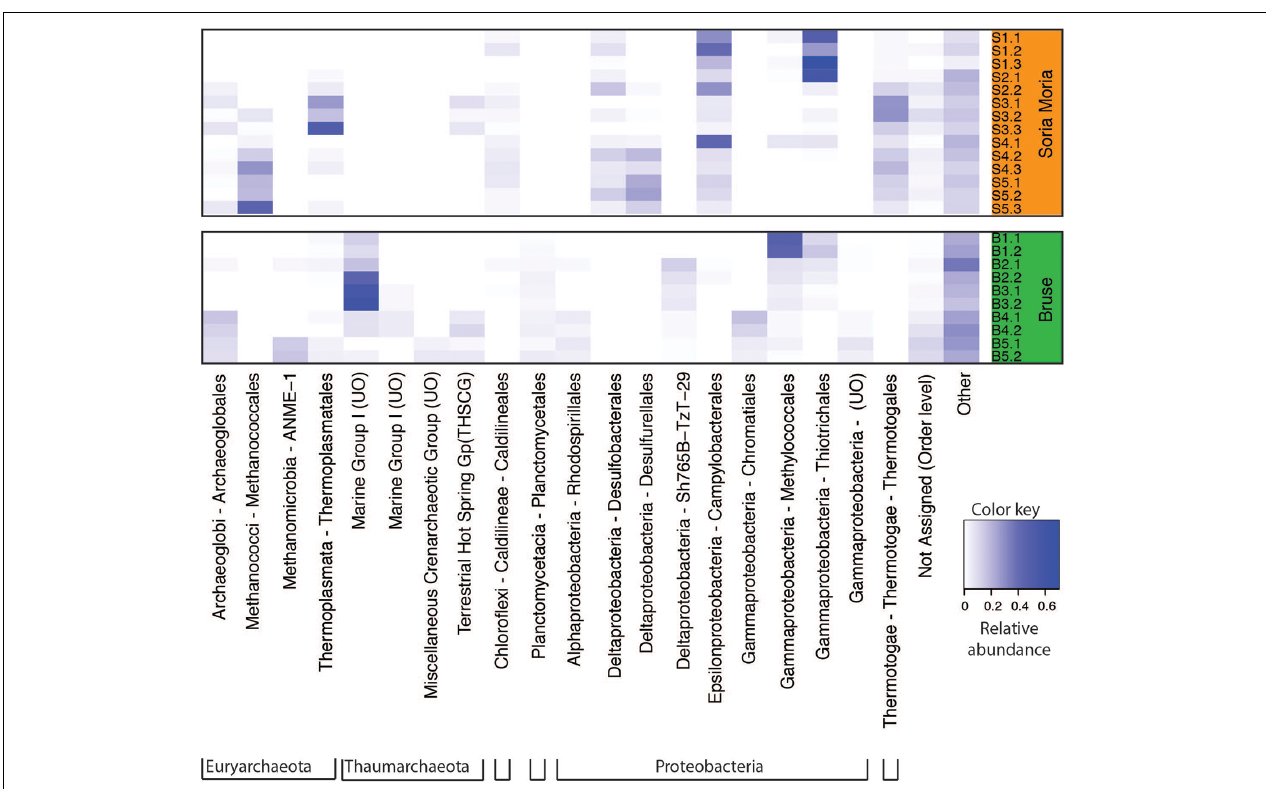
FIGURE 4 | Heatmap of relative abundances of dominating taxa (at least one sample with relative abundance > 1%) at the order level. Sample names correspond to the short names given in Table 1 . UO, unnamed